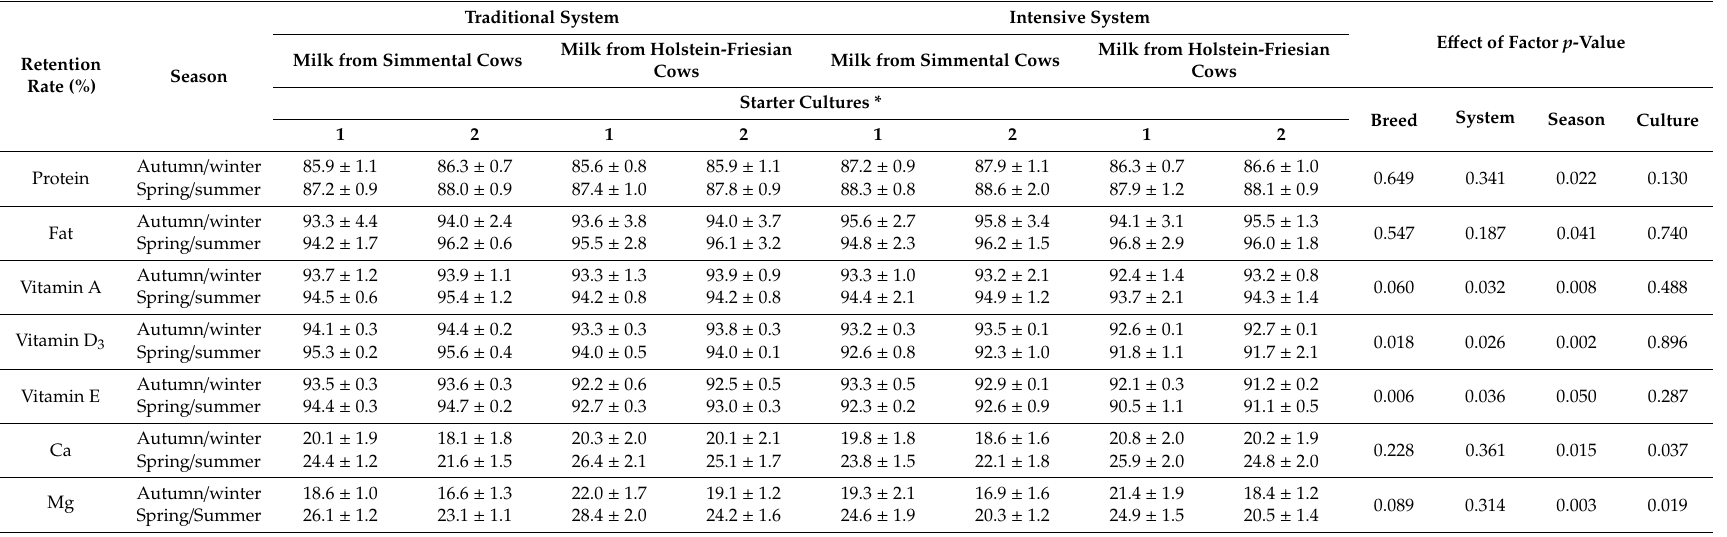
Table 4. Retention rates of protein, fat, selected fat-soluble vitamins, and macro-elements from raw milk to curd cheese, depending on the experimental factors ( x ± SD).